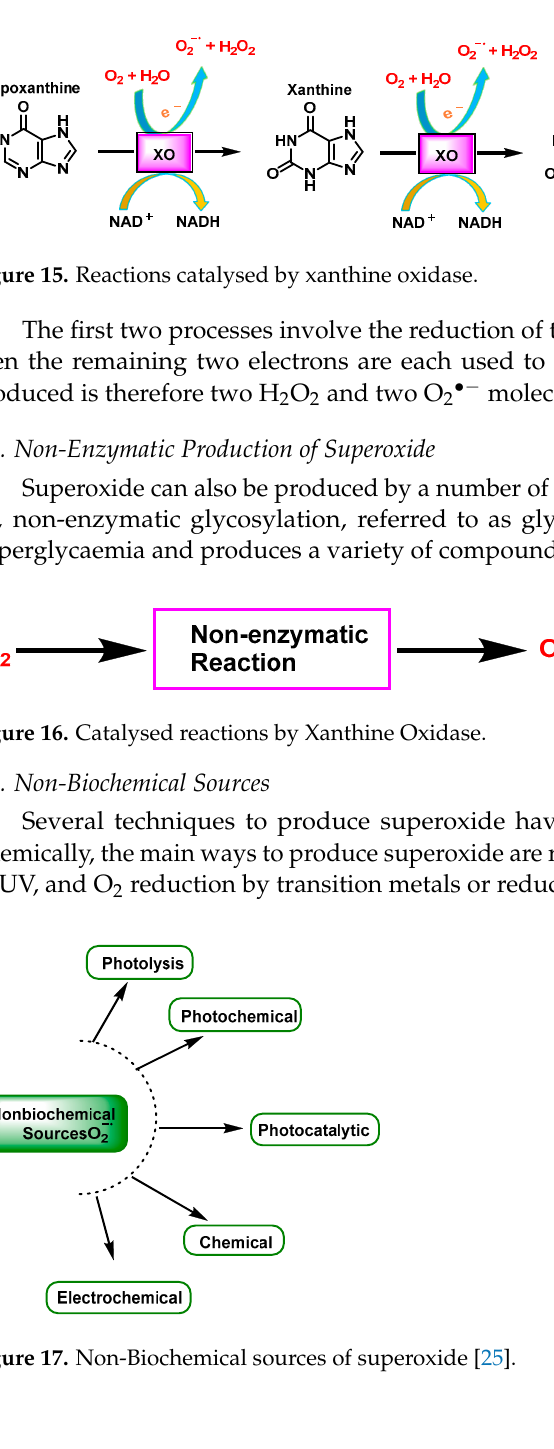
Figure 17. Non-Biochemical sources of superoxide [25].